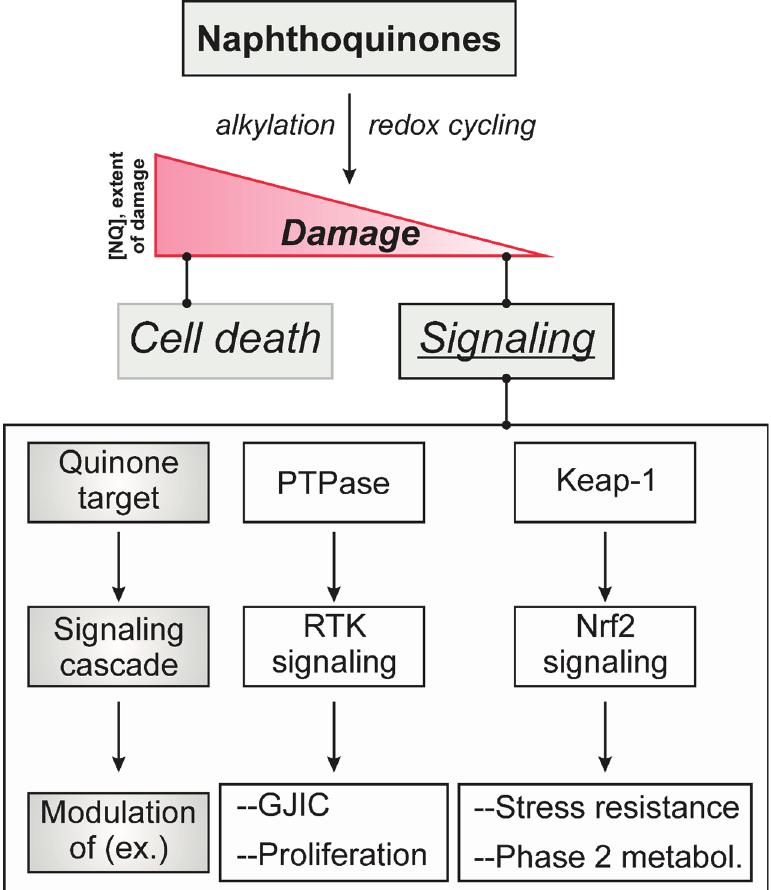
Figure 3. Alkylation and redox cycling as initiators of naphthoquinone-induced signaling. Naphthoquinones (NQ), via oxidation or alkylation of cellular target structures, cause damage that may result in cell death. Stimulation of signaling cascades is triggered already at lower concentrations of NQ (with less extensive damage elicited). The figure provides examples of primary NQ target structures mentioned in the text, signaling cascades stimulated and biological effects